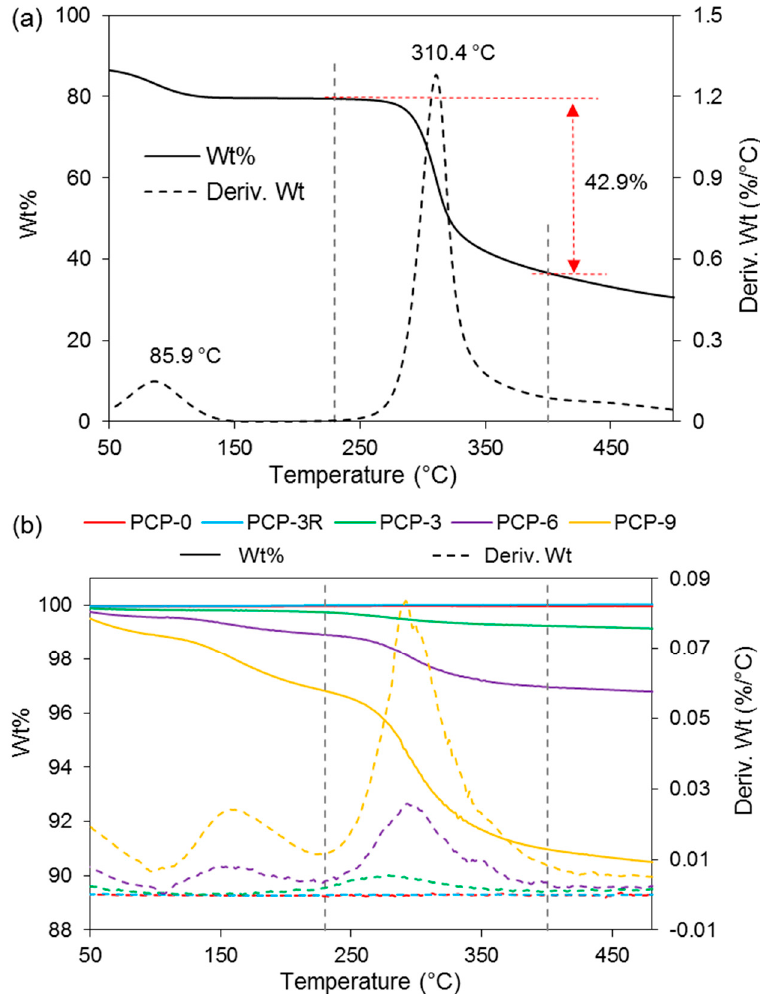
Figure 4. Weight percentage and derivative of weight percentage (Deriv. Wt) for ( a ) CS powder and ( b ) coated/uncoated PGFs. The main weight loss was observed between 230 and 400 °C. The red dashed line and arrow in ( a ) were added for eyes guide. Table 3. Peaks of the Deriv. Wt (the derivative of weight percentage) curves and weight loss in the temperature region of 230–400 °C ( n = 3).